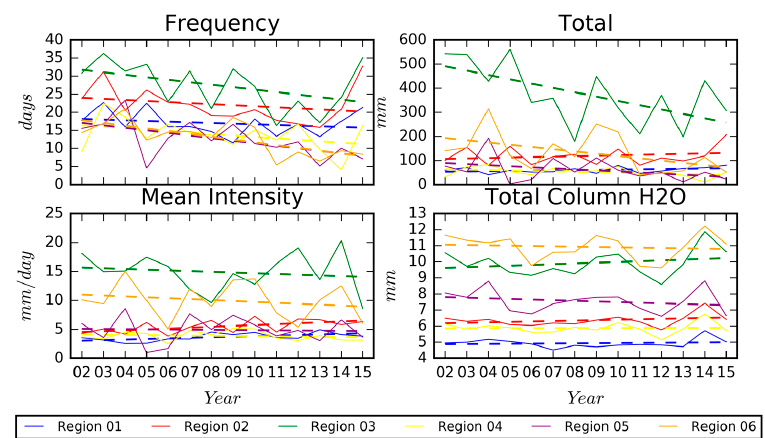
Figure 9. The solid lines indicate the mean time series of frequency (number of days), totals (mm), mean daily intensity (mm/day), and total column water vapor (mm) within the sub-regions. Dashed lines are the slope of change based on linear regression analysis for the solid lines.